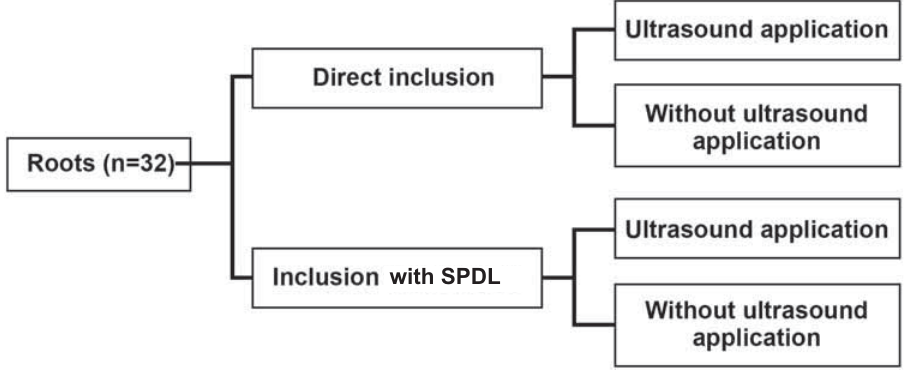
Figure 1- Experimental design